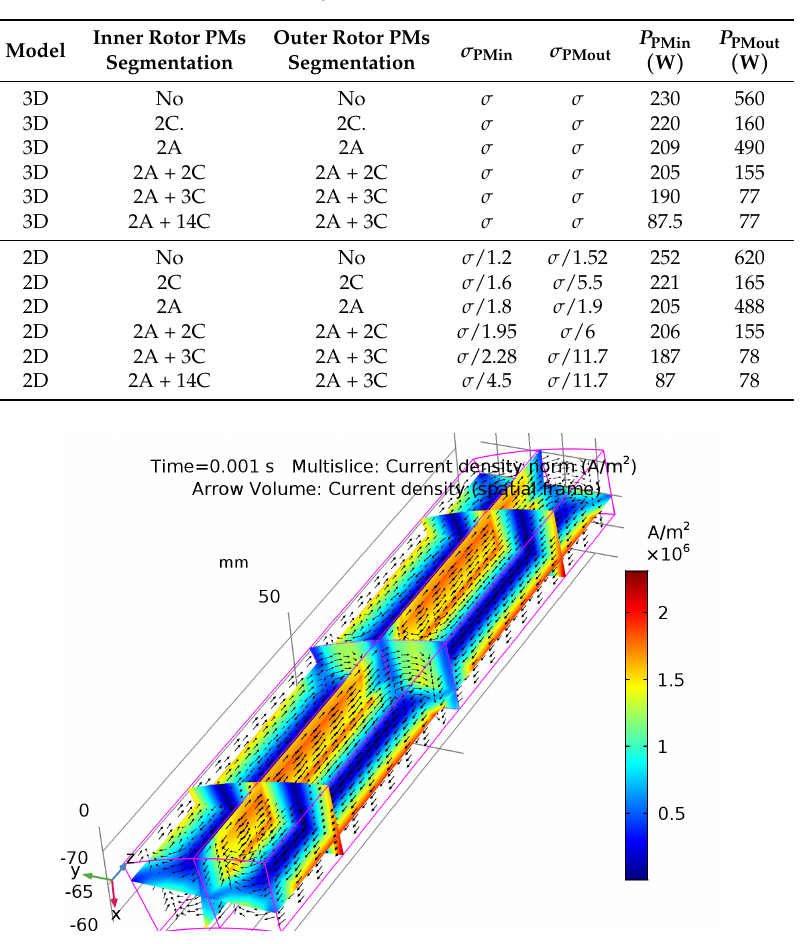
Figure 6. Effect of outer PMs segmentation on eddy currents: current density norm (multi-slice colormap) and current density vectors (black arrows). The figure refers to the 3D simulation with two axial segments and two circumferential